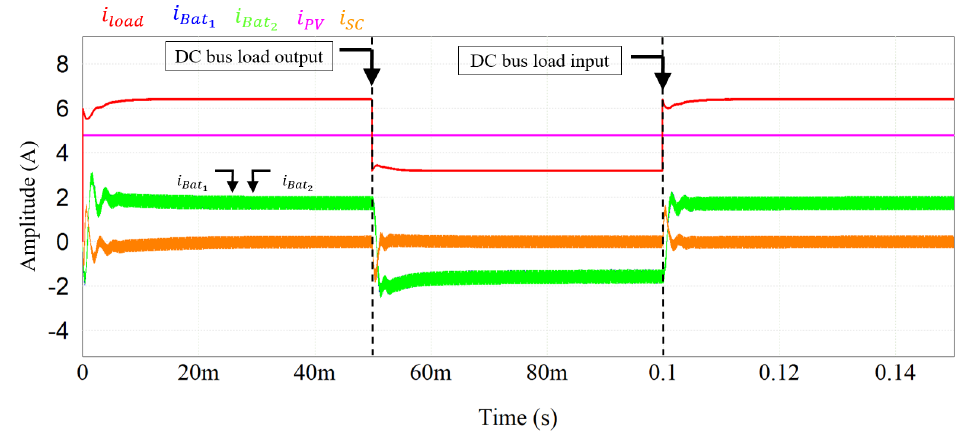
Figure 8. Dynamic and static response currents of system with FBM conventional control.